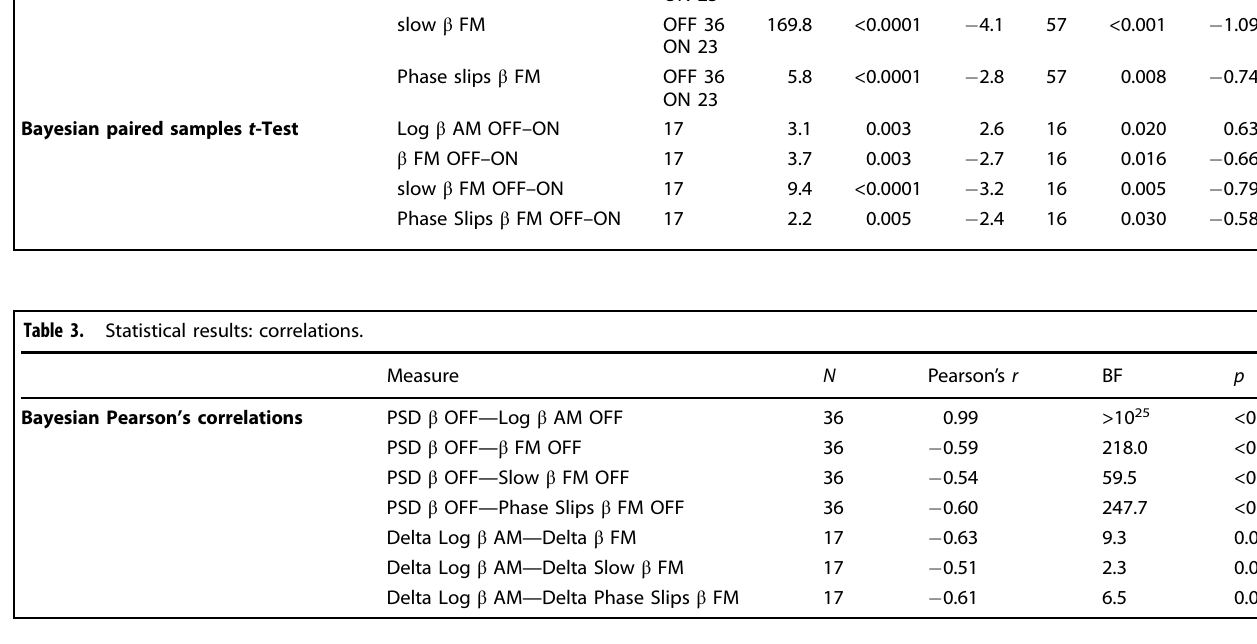
Table 2. Statistical results: means. Bayesian independent samples t -Test